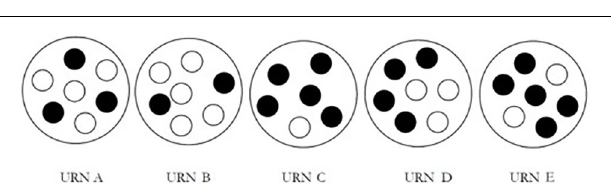
FIGURE 2 | Experimental version of the